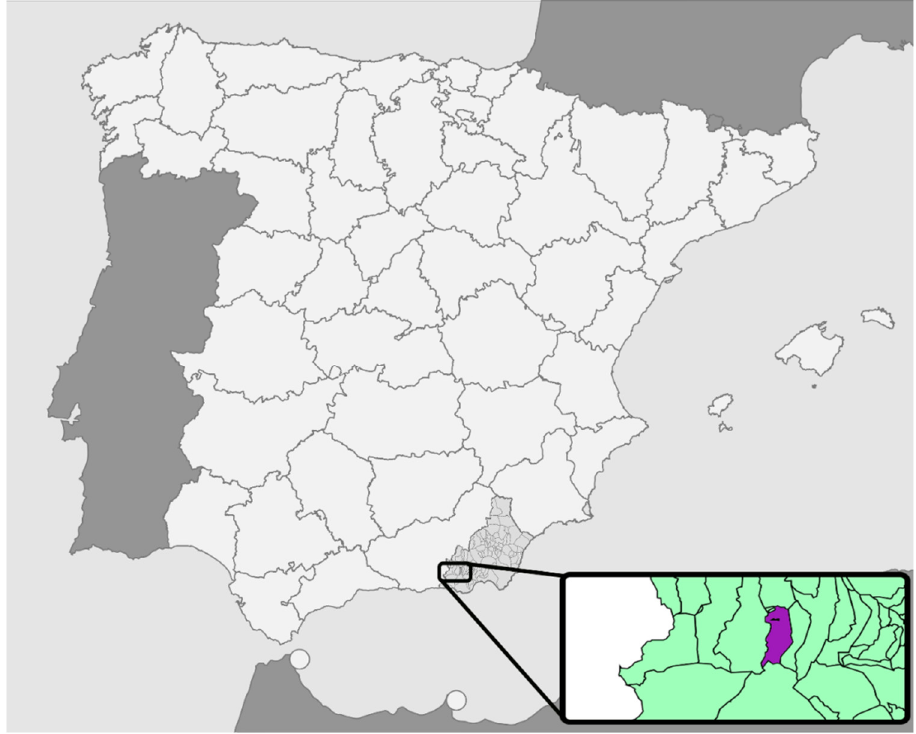
Figure 1. Location of the municipality of Almócita (Spain). Source: Own elaboration. Almócita has 197 inhabitants, being one of the 10 municipalities with the smallest population in the province [73]. Indeed, its population fell by more than half during the last century [74]. It is located at a distance of approximately 47 km from the capital [73] and has a classic Arabic urban structure made up of simple, white houses located in small, sloping, winding streets. The town is essentially agricultural with grapes having been the key crops for centuries.